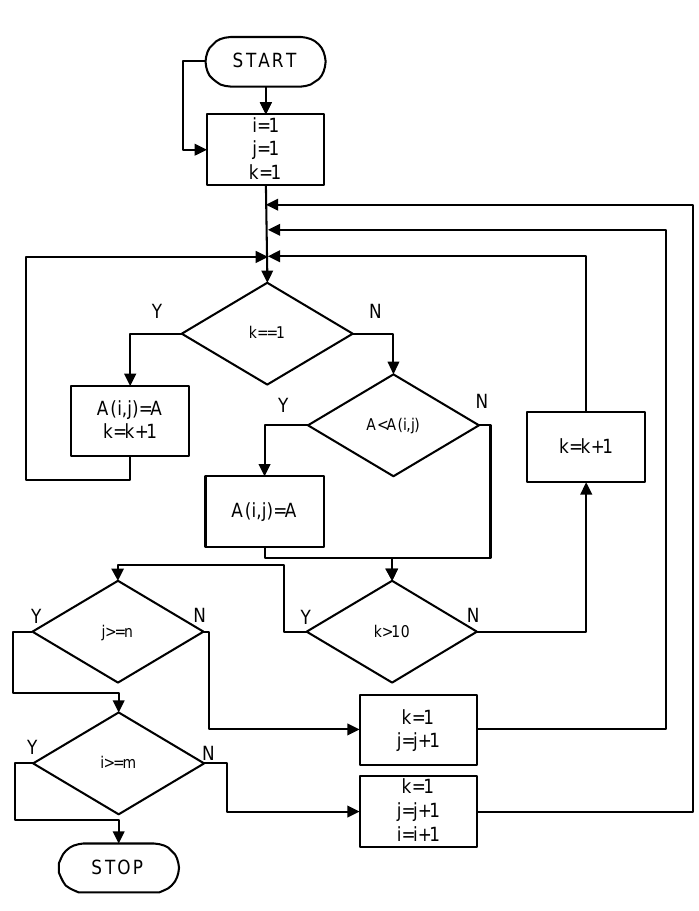
Figure 6. Flow diagram of the algorithm controlling the calculations, where i — protein index; j — ligand index; k — search variant index; m — number of proteins; n — number of ligands; A — affinity for the current protein and ligand; A set — set of affinity values.